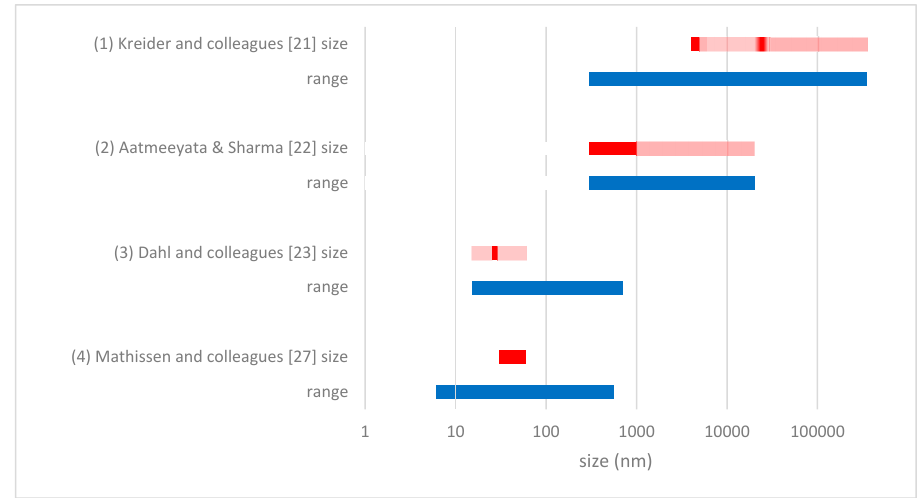
Figure 1. Size ranges of tyre wear and tear covered (blue bars) and detected (red bars) in four different studies (see text). Dark red suggests the size of the major number of particles [21–23,27]. 2.2. National Estimates on the Amount of Wear and Tear from Tyres Two different approaches are typically used to estimate the amount of wear and tear from tyres.